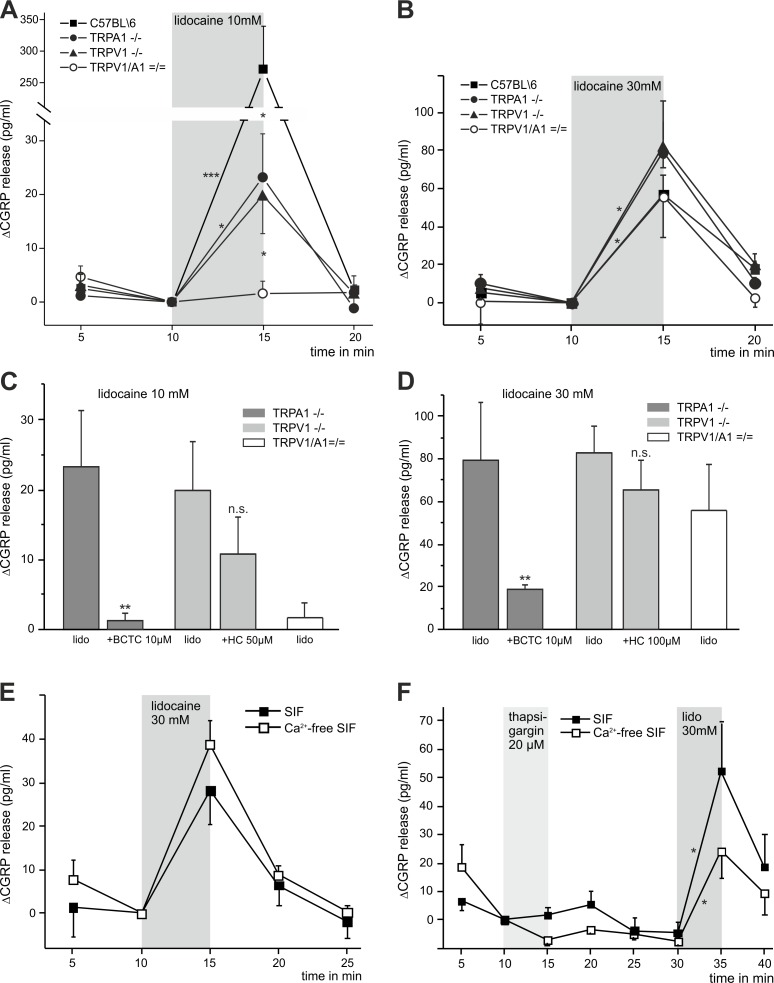
TRPA1 and TRPV1 differentially contribute to lidocaine-stimulated CGRP release from peripheral axons.Sciatic nerves from mice were isolated, stimulated with lidocaine and/or chemical substances (where stated) for 5 min, and induced CGRP-release over baseline was measured quantitatively. A. Lidocaine 10 mM and B. 30 mM stimulated CGRP release from C57BL/6 nerves (10mM: p = 0.0004, n = 16; 30 mM: p = 0.012, n = 8). In nerves from TRPA1-/- and TRPV1-/- mice less CGRP was released by lidocaine 10 mM (both p = 0.012, n = 8), while stimulation was without any effect on CGRP release from TRPV1/TRPA1 = / = nerves (p = 0.674, n = 8). B. Stimulation with 30 mM lidocaine induced release of CGRP of comparatively the same extent in nerves from TRPA1-/-, TRPV1-/- (both p = 0.012) and TRPV1/TRPA1 = / = mice (p = 0.017, all n = 8). C, D. Effects of additional application of either the TRPV1 inhibitor BCTC (10 μM) in TRPA1-/- (lidocaine 10 mM: p = 0.003, 30 mM: p = 0.002, both n = 8) or the TRPA1 blocker HC030031 (50 μM) in TRPV1-/- (n.s., n = 8 each) E. In C57BL/6 nerves CGRP release stimulated by lidocaine (30 mM) was nearly the same in calcium free as in calcium containing solution (n = 4). F. Initial application of thapsigargin (20 μM, 5 min) reduced subsequent CGRP release evoked by lidocaine (30 mM) to the half in Ca2+-free extracellular solution (p = 0.028, n = 8). Data are presented as mean ± SEM. For intra-individual comparison the Wilcoxon matched pairs test and for group comparison the Mann-Whitney U test were calculated.